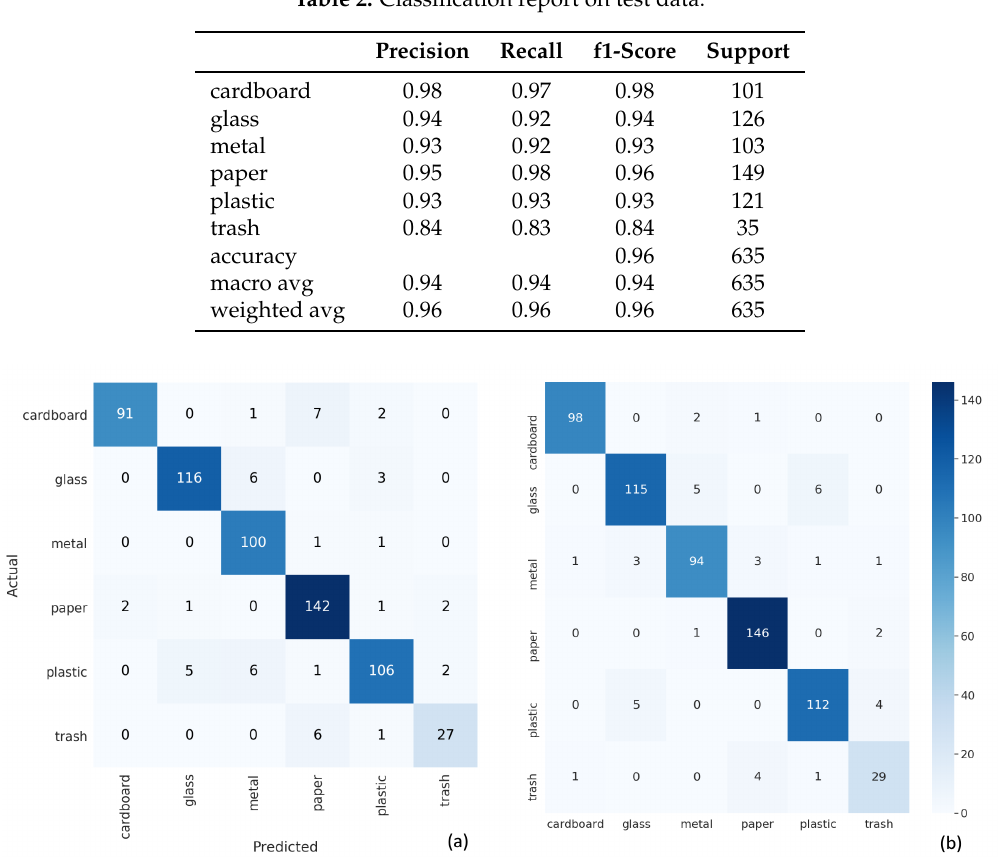
Figure 4. Confusion matrix of our model on ( a ) train and ( b ) test data. As we can see the model confused mostly samples of metal/glass and plastic/metal.